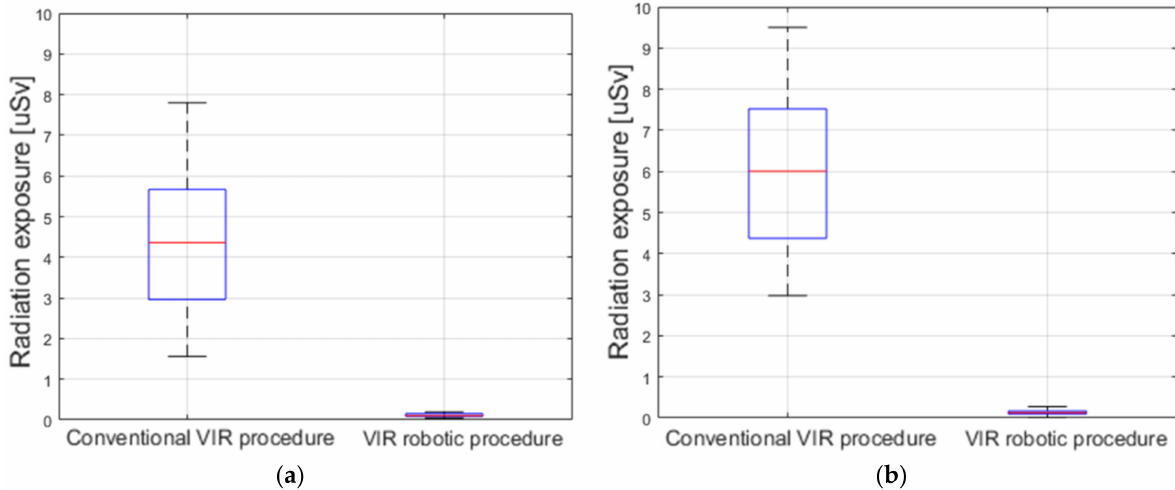
Figure 11. Measurement results of the radiation exposure to the operators during conventional and robotic VI procedures. The measured radiation exposure during the procedure for ( a ) hepatic artery target 1; and ( b ) splenic artery target 2.